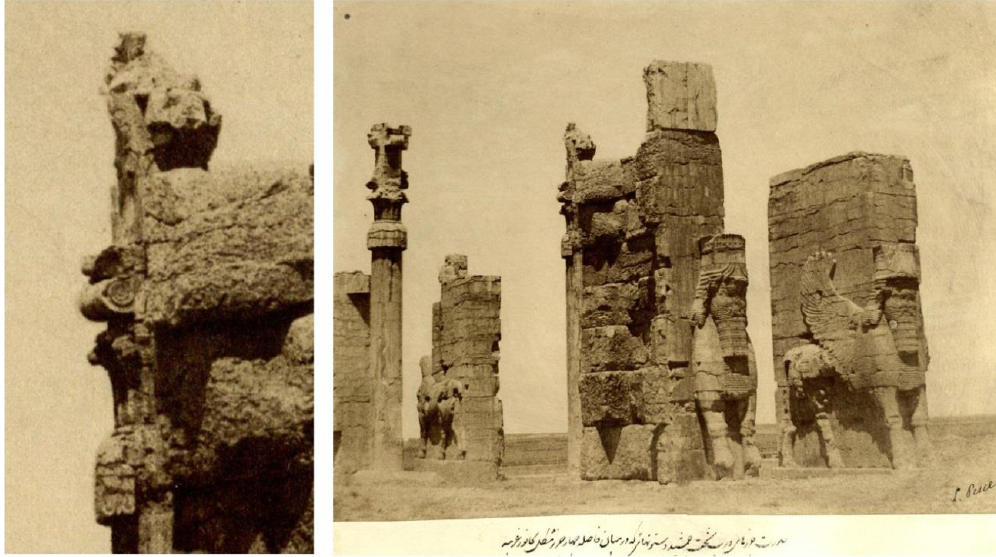
Figure 9. The first photograph made from the Gate in 1857–58 by L. Pesce. © The Golestān Palace Photo-House.